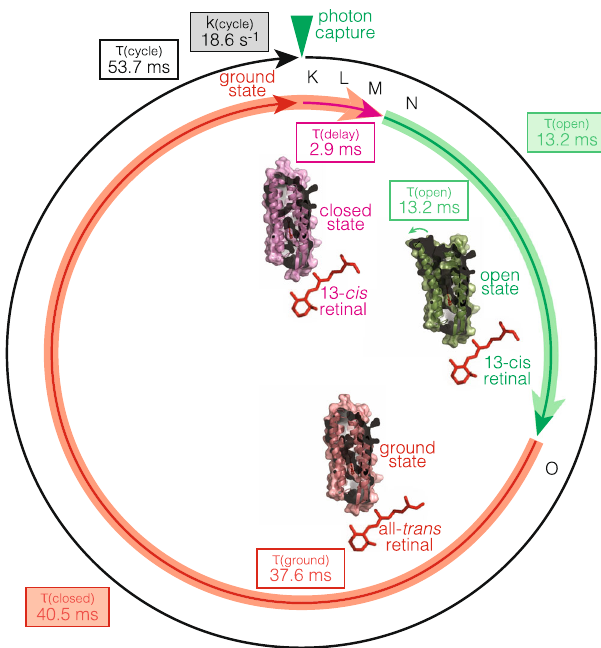
Fig. 4 bR-WT reaction cycle kinetics in the purple membrane. After photon capture and isomerization of the retinal from all- trans to 13- cis , bR is in a closed state structure for 2.9 ms (pink), comprising states K, L and M. For re-protonation of the retinal, bR opens the cytoplasmic gate displacing the E-F loop and stays in the open state structure for 13.2 ms (green), corresponding to state N. The green arrow highlights the movement of the E-F loop to open the cytoplasmic gate. After retinal re-protonation and isomerization to all- trans , bR relaxes to the dark state structure (red). Under continuous light at saturating conditions, the protomer stays in the closed state for 37.6 ms (40.5 ms − 2.9 ms), until it can be activated again. We propose that, during this time, the neighboring protomers cycle (2 × 2.9 ms + 13.2 ms = 32.2 ms). The structure shown are PDB 6RNJ, 6RPH and 6RQP 7